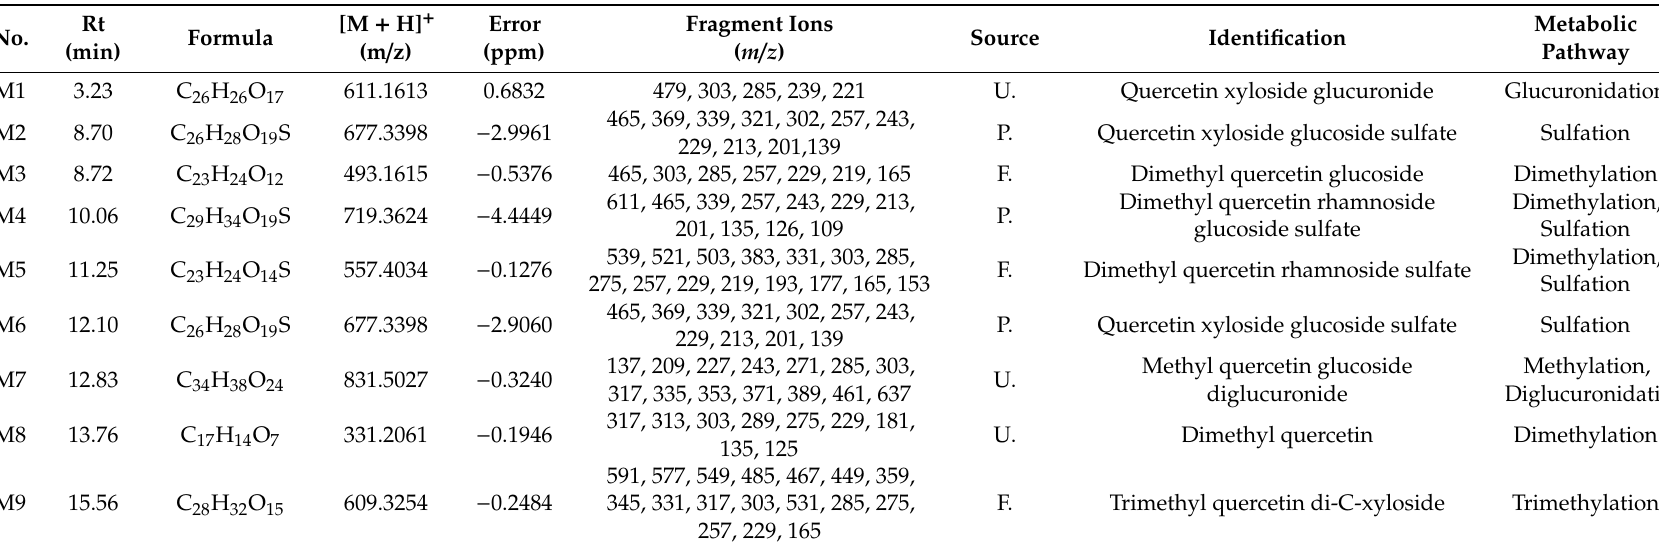
Table 3. Identification of 9 novel metabolites in beagle dog urine, feces, and